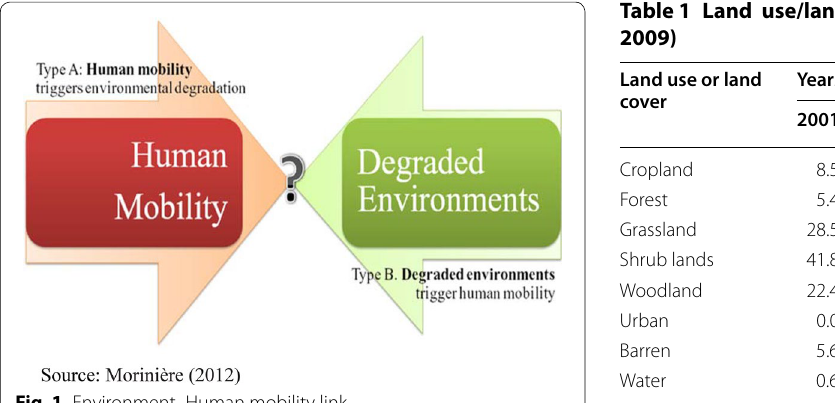
Fig. 1 Environment–Human mobility link